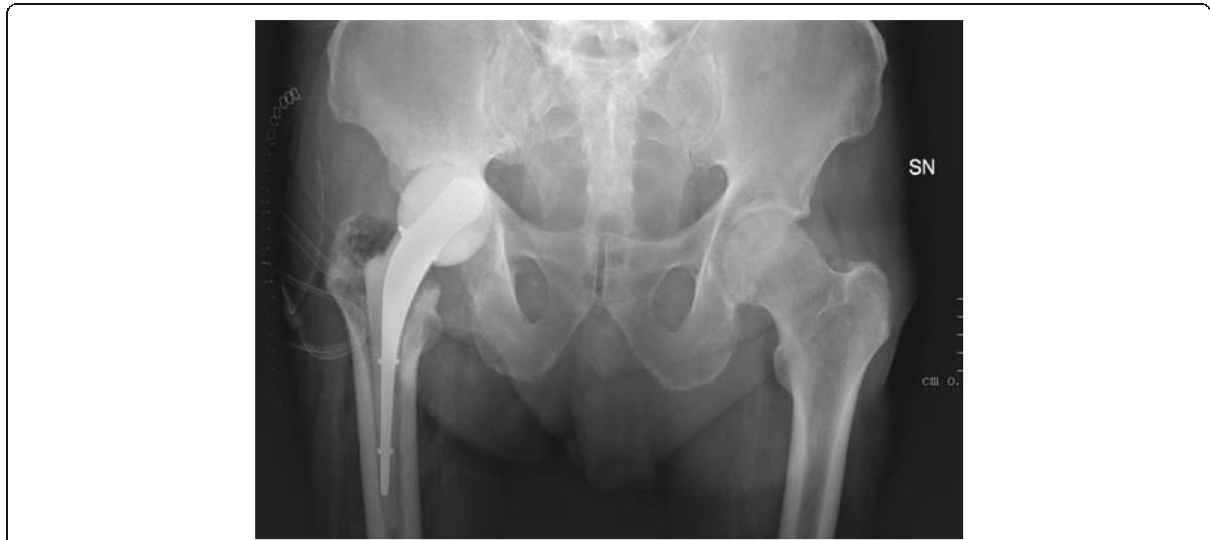
Fig. 2 Removal of the prosthesis and implant of the spacer